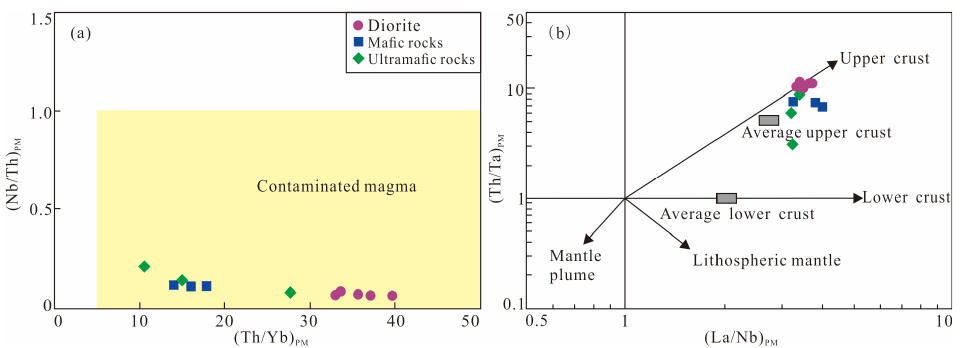
Figure 10. Diagrams of ( a ) Th/Zr versus Nb/Zr (modified after [96]) and ( b ) Sr/Nd versus Th/Yb (modified after [97]) of the mafic–ultramafic rocks, showing the addition of slab ‐ derived melts or sediment contaminants in mantle sources.